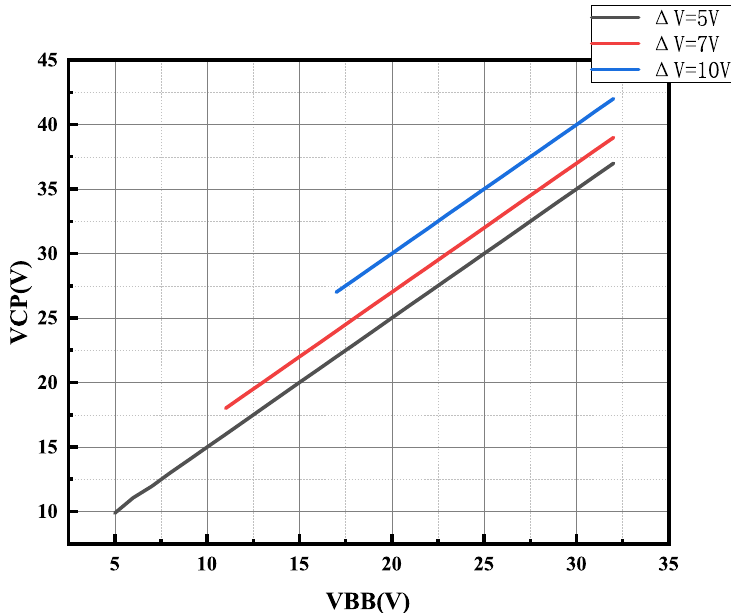
Figure 13. Simulation results of the output signal when the supply voltage